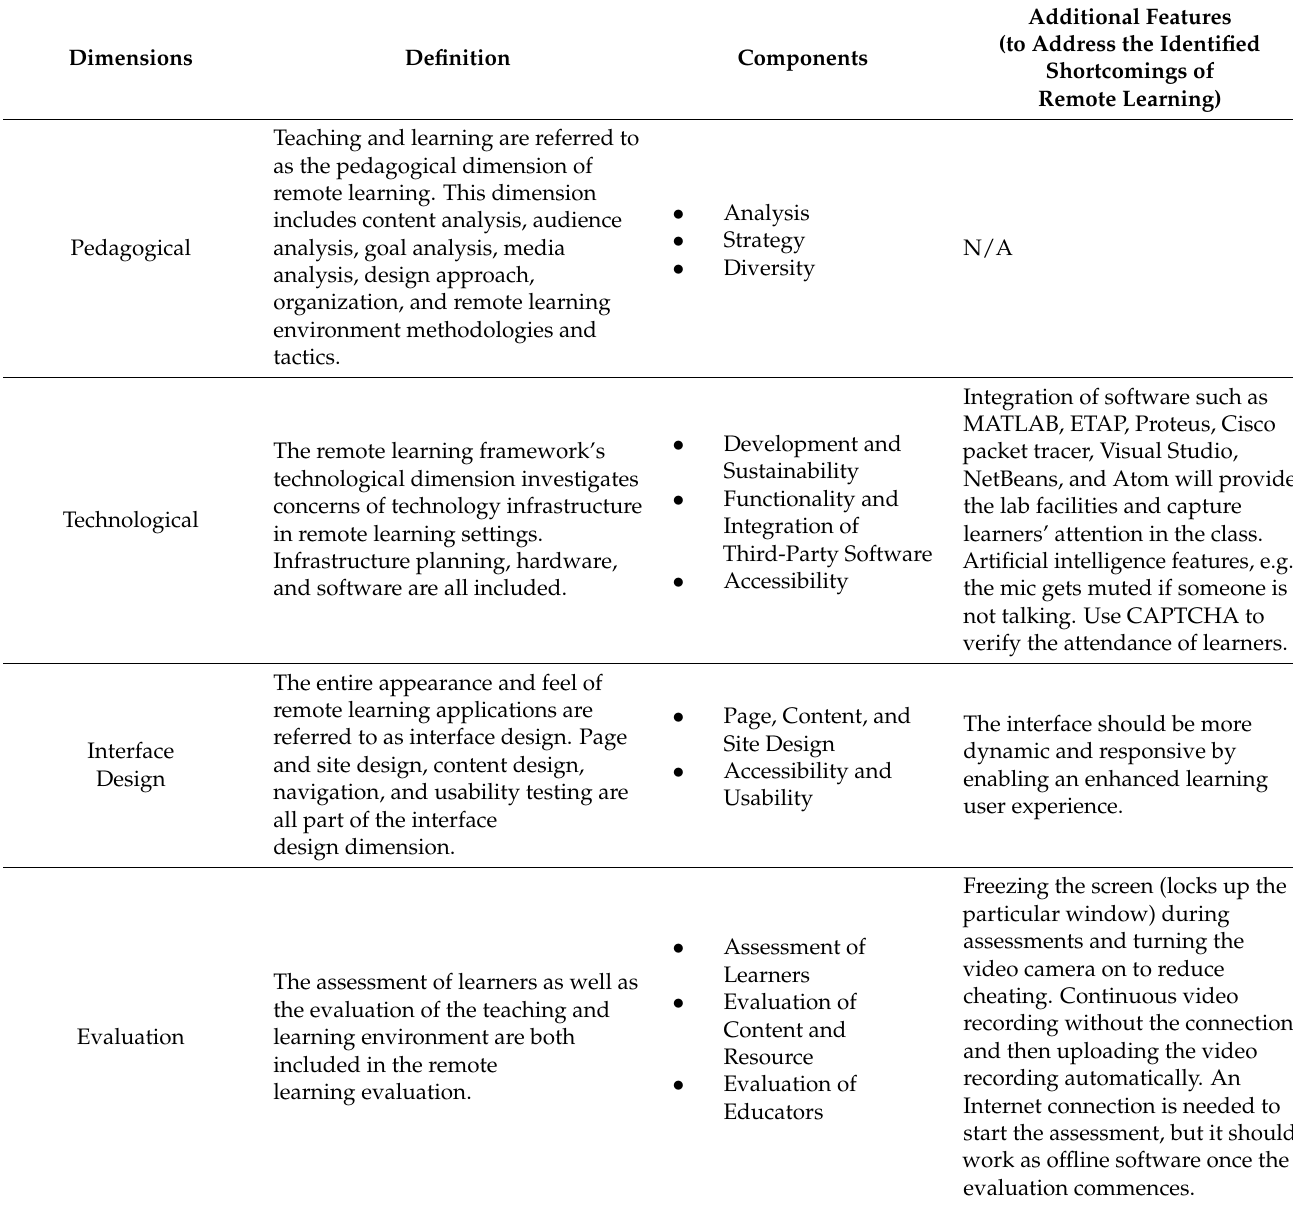
Table 3. Dimensions, Definitions, Components, and Additional Features of C19MOOC